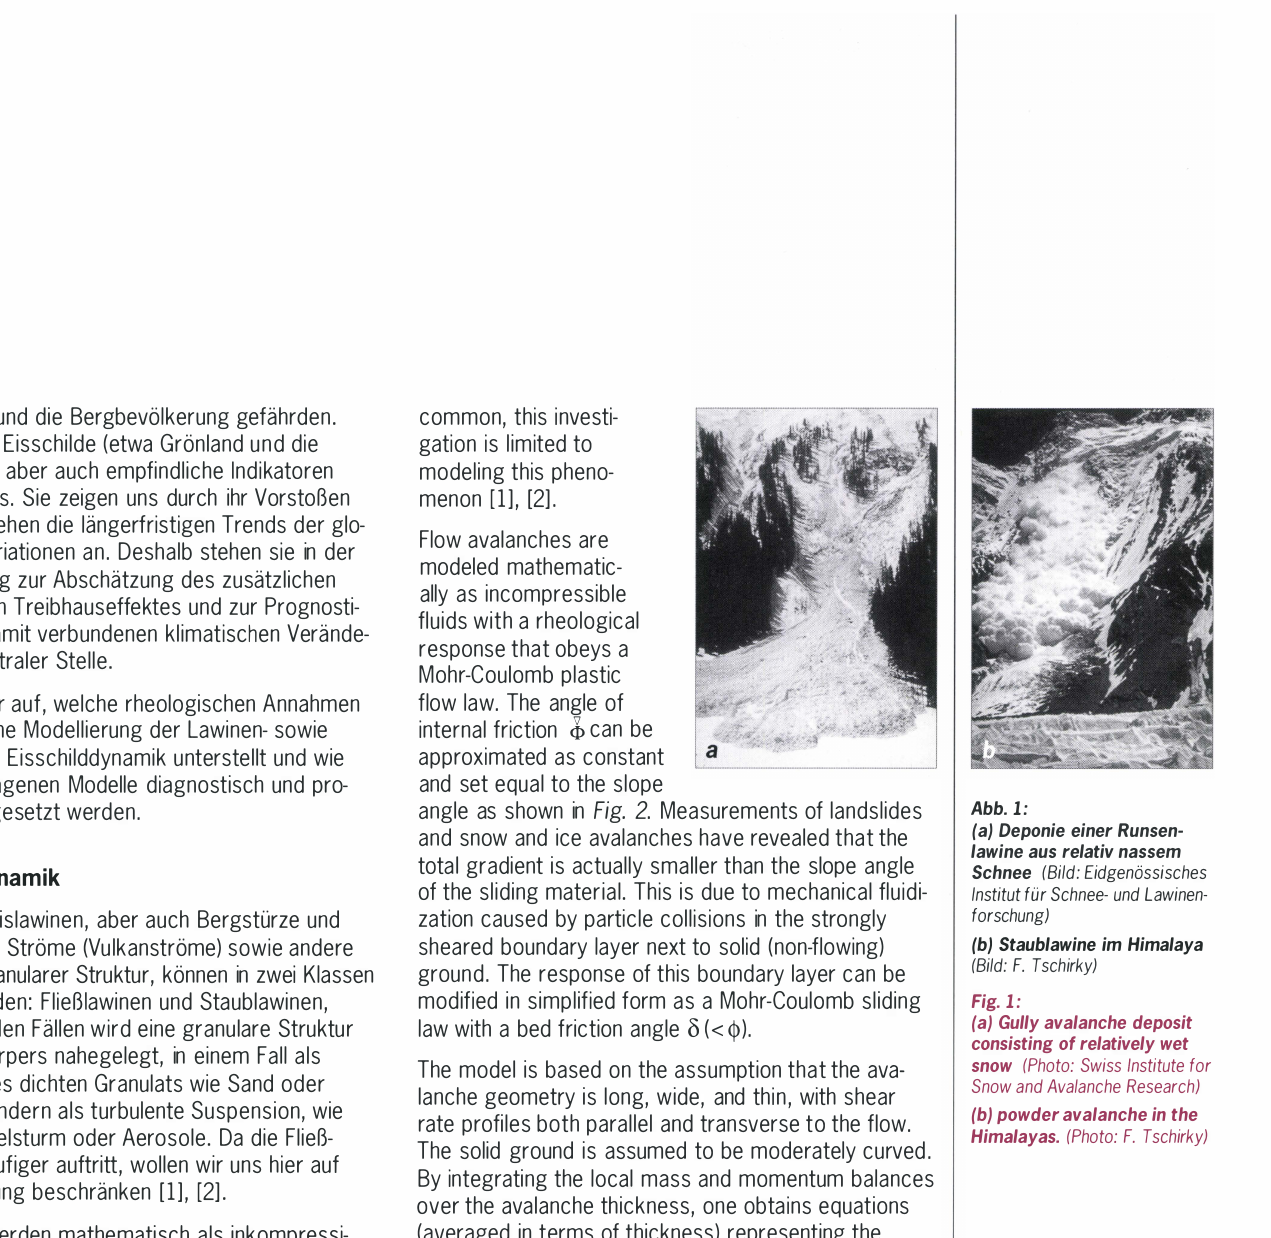
(averaged in terms of thickness) representing the